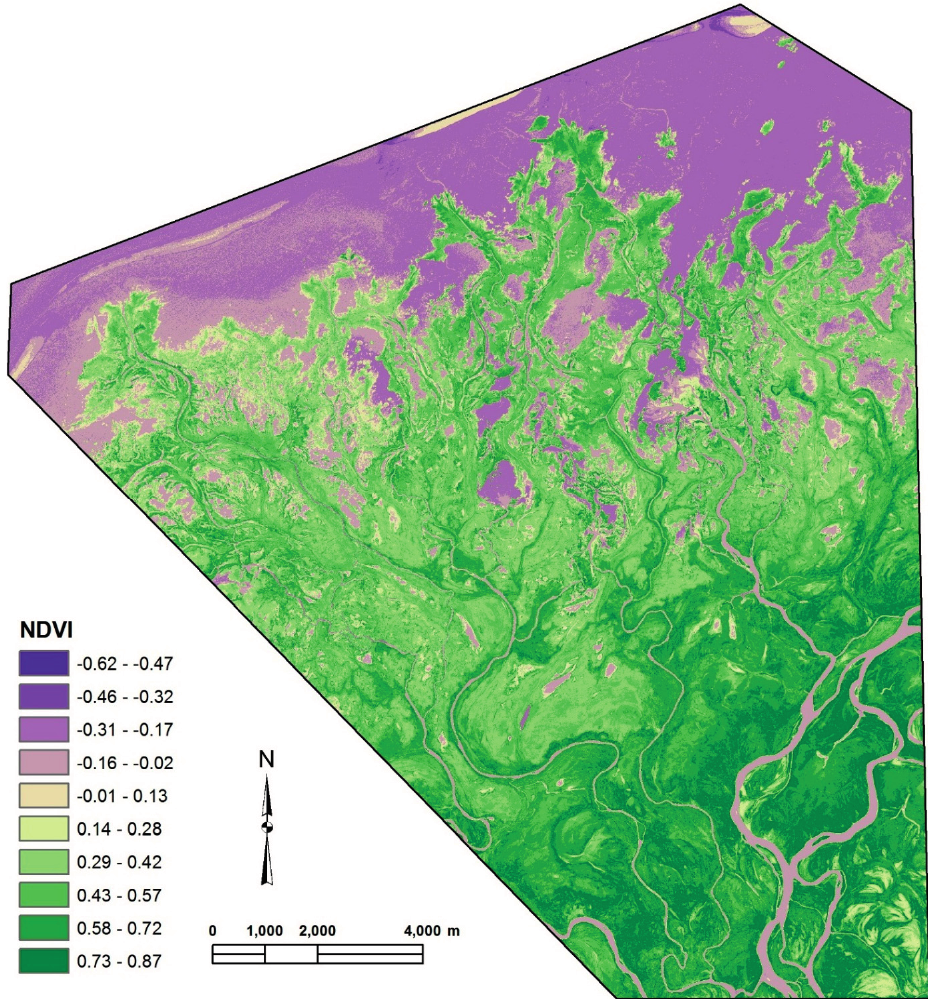
Figure 3. Normalized Difference Vegetation Index (NDVI) derived from the near-infrared 1 (NIR1) and red